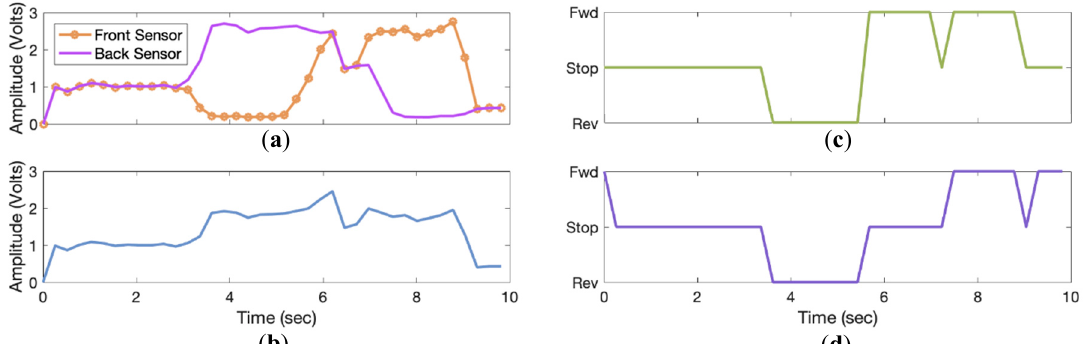
Figure 7. ( a ) Simulated post-processed front and back sensor signals, ( b ) calculated tether distance, ( c ) direction of left powered wheelchair motor driven using a differential drive system (directions correspond to tether distance and simulated sensor voltages), ( d ) direction of right powered wheelchair motor driven using a differential drive system (directions correspond to tether distance and simulated sensor voltages).